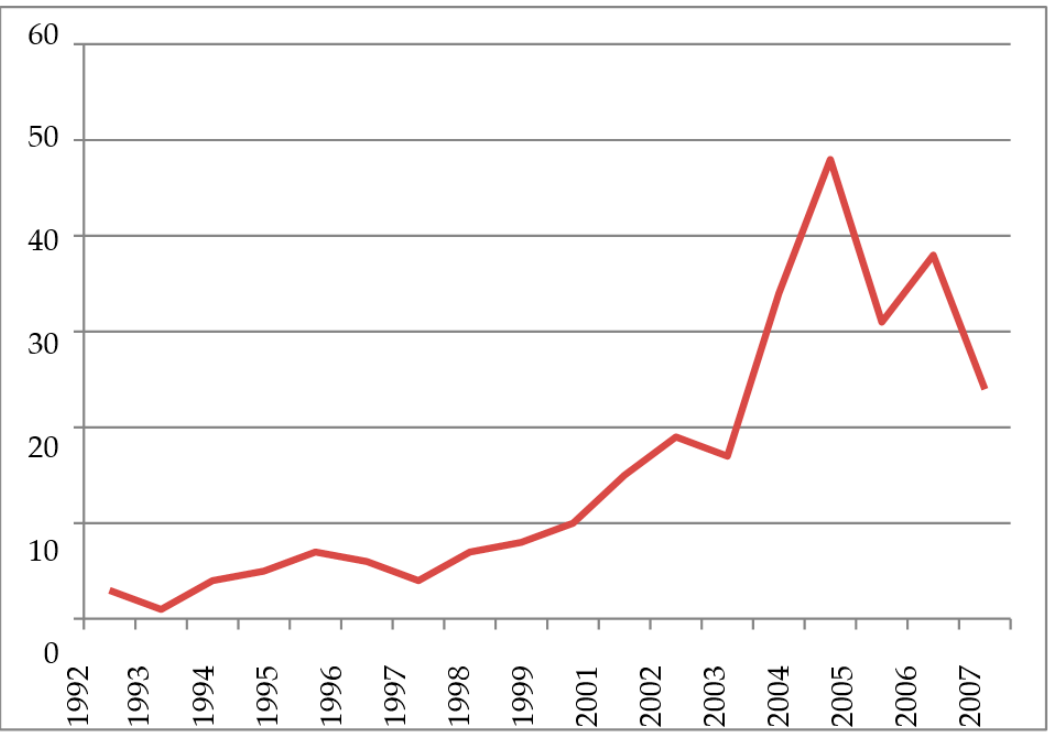
Figure 1. Number of deals by year (Source: study sample).